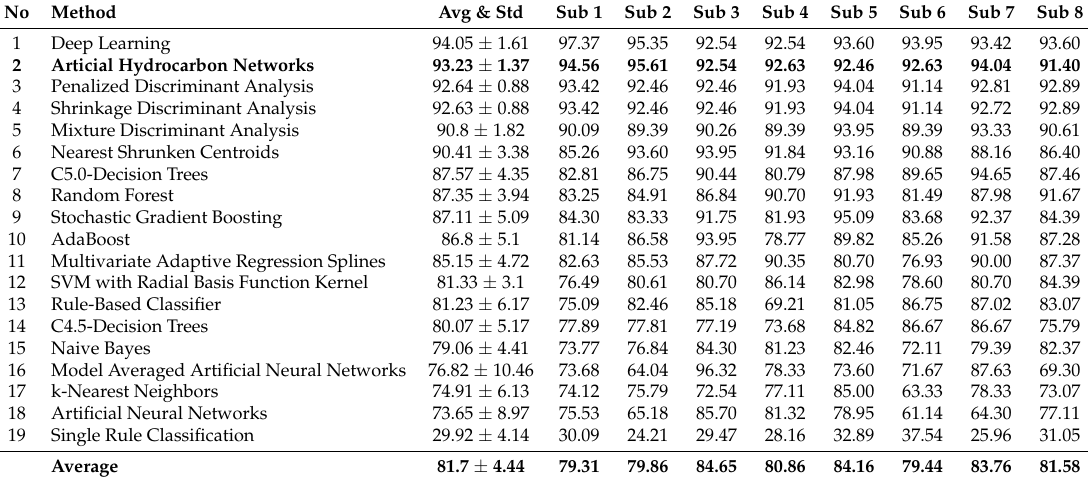
Table 8. Results of case 2: Leave-one subject-out performance for the user-independent approach for each of the models